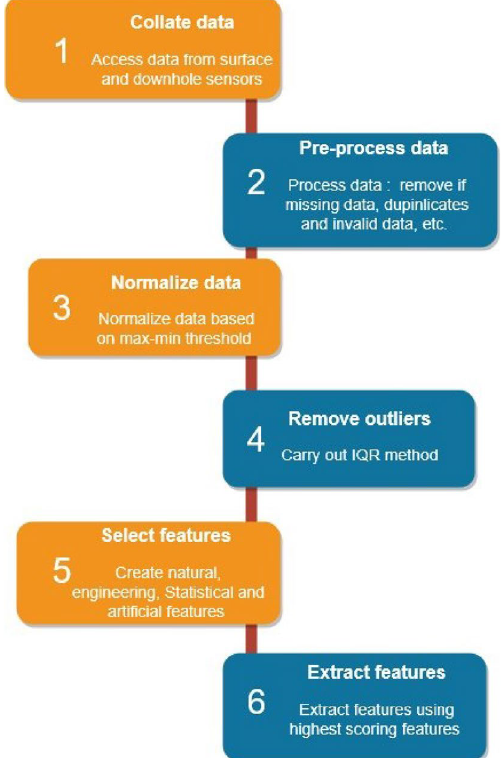
Fig. 4 Flowchart of data flow and processes performed for